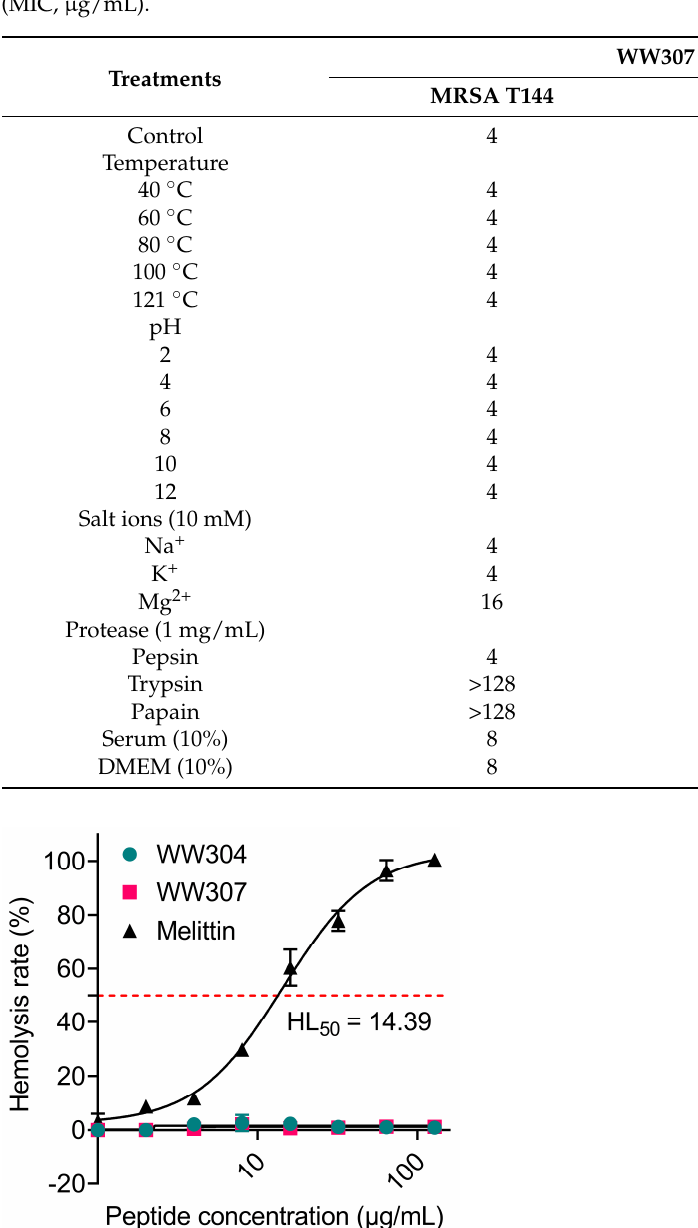
Table 3. Thermal, pH, salts and protease stability of WW307 against MRSA T144 and E. coli B2 (MIC, µ g/mL).